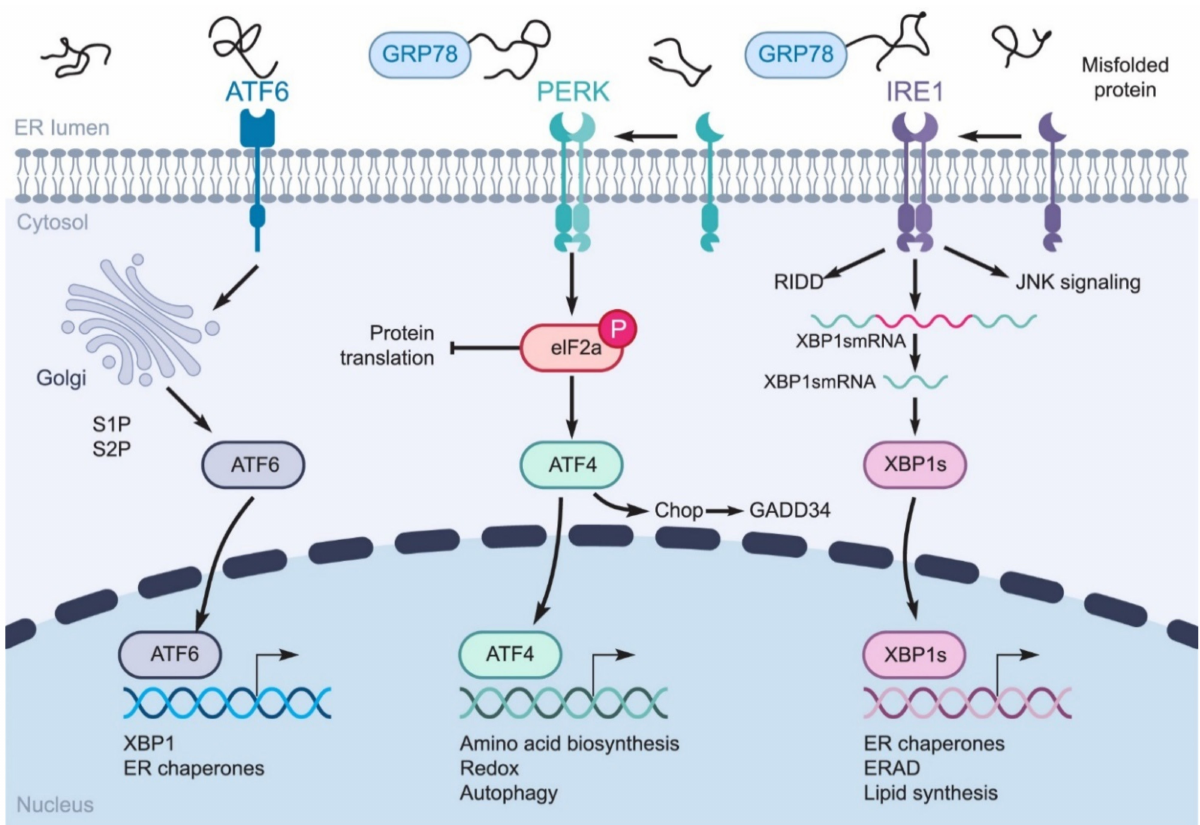
Figure 1. UPR signaling pathways . IRE1 α , PERK, and ATF6 are three sensors of the UPR pathway. ER stress releases GRP78 from these sensors. After this release, activated PERK induces the eukaryotic initiation factor 2 α (eIF2 α ) phosphorylation and ATF4 is activated and translocated to the nucleus to trigger the transcription of certain genes. IRE1 α is autophosphorylated and oligomerized in response to ER stress. The activated IRE-1 provides the active form of the X-box binding protein (XBP1) transcription factor mRNA, which contributes to protein folding by regulating the expression of genes related to the proper unfolding of proteins and the secretion and destruction of the ER proteins. ATF6 is processed by Site-1 protease (S1P) and Site-2 protease (S2P). Activated ATF6 also translocates to the nucleus and, as a transcription factor, induces the transcription of ER chaperones. IRE1: inositol-requiring enzymes; PERK: protein kinase R (PKR)-like ER kinase; ATF6: activating transcription factor 6; GRP78: glucose-regulated protein 78; eIF2: eukaryotic initiation factor 2; ATF4: activating transcription factor 4; XBP1: X-box binding protein; ERAD: endoplasmic-reticulum-associated protein degradation; GADD34: growth arrest and DNA damage inducible protein 34; RIDD: regulated IRE1-dependent decay; JNK: c-Jun N-terminal